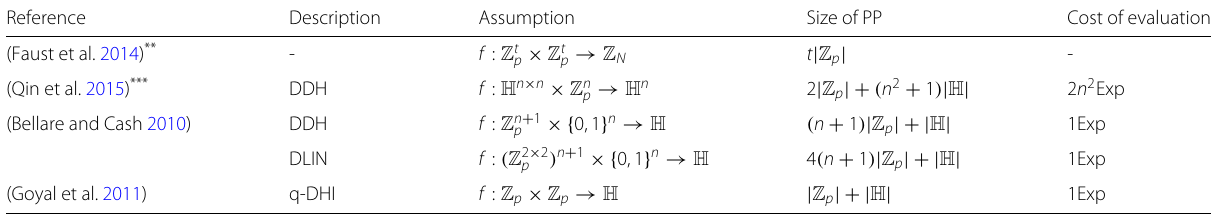
Table 3 Theoretical analysis of TRF Reference